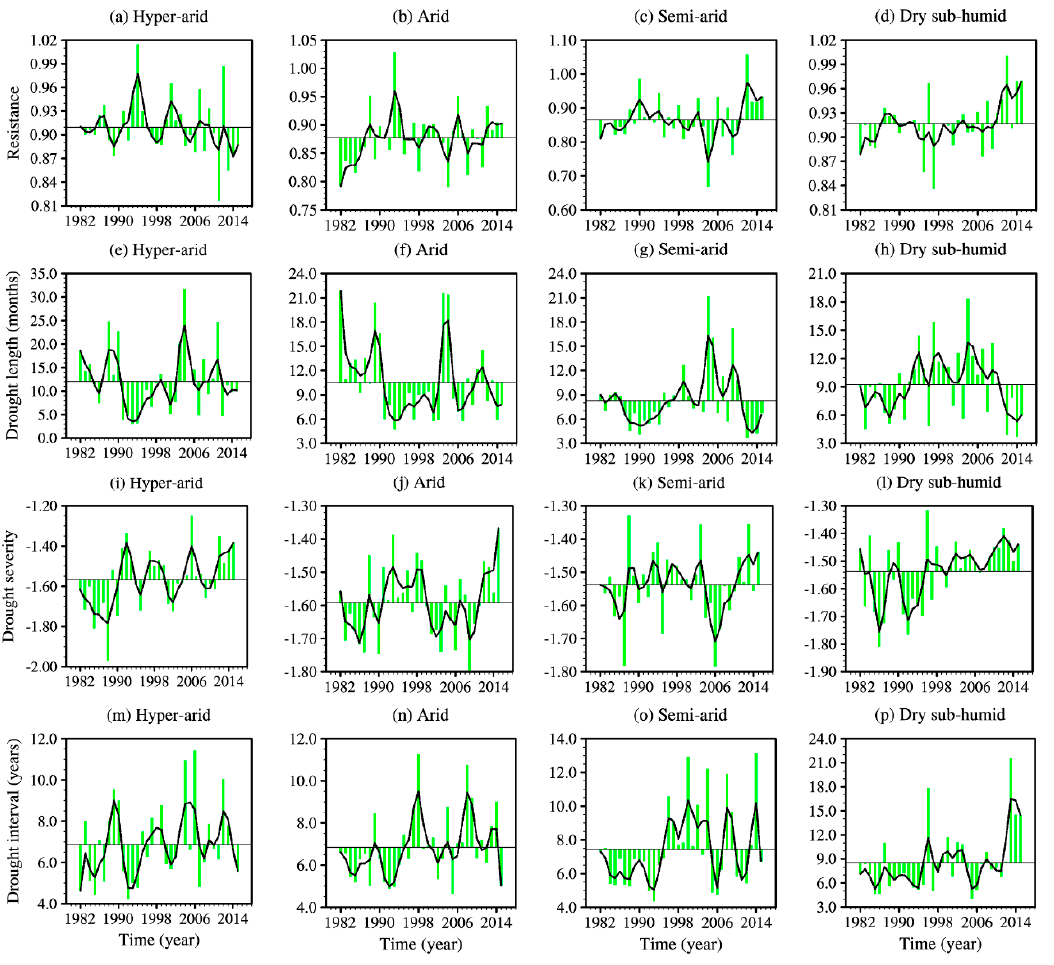
Figure 2. Temporal trends in ( a – d ) resistance, ( e , h ) drought length, ( i – l ) severity, and ( m – p ) interval in ( a , e , i , m ) hyper-arid, ( b , f , j , n ) arid, ( c , g , k , o ) semi-arid, and ( d , h , l , p ) dry sub-humid regions between 1982 and 2015. The black line is the three-point smoothing curve.